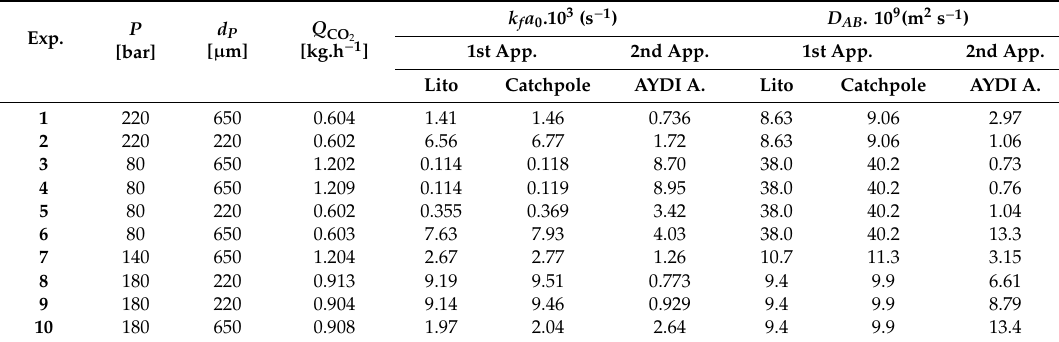
Table 10. Parameters ( k f a 0 , and D AB ) between two approaches.